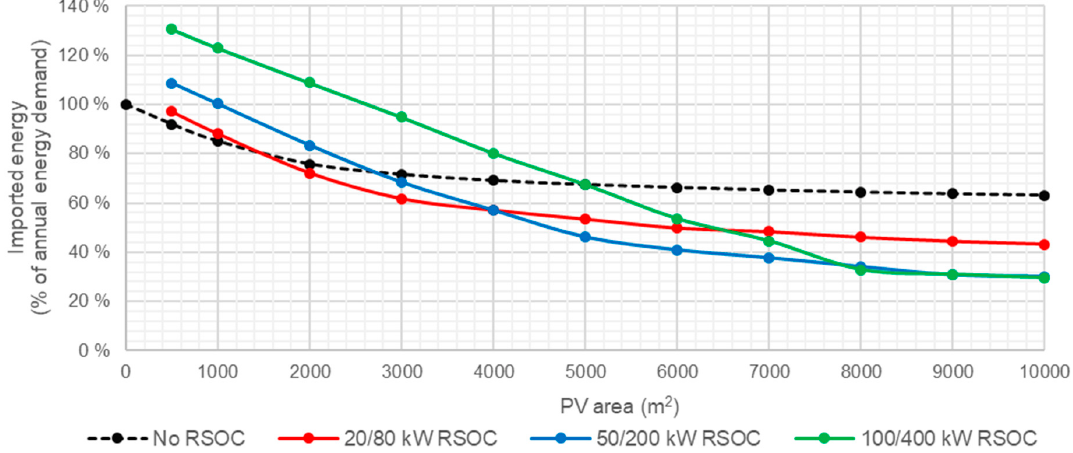
Figure 8. Annual imported energy (electricity and heat) (for the optimal hydrogen storage size) as a function of installed solar PV panel area for the three RSOCHS systems and the reference system.